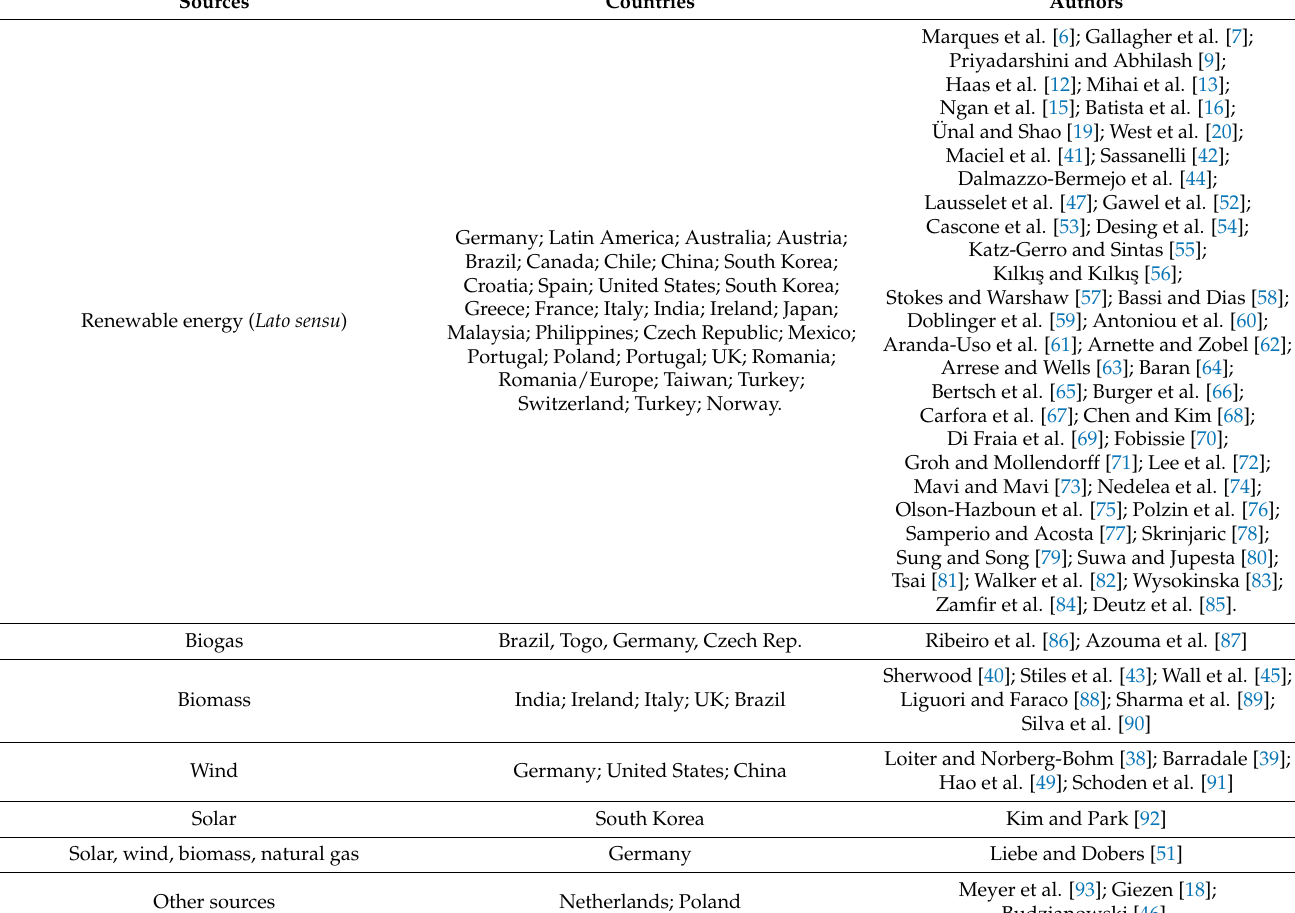
Table 5. Systematic classification of public policies by renewable energy sources and their respective